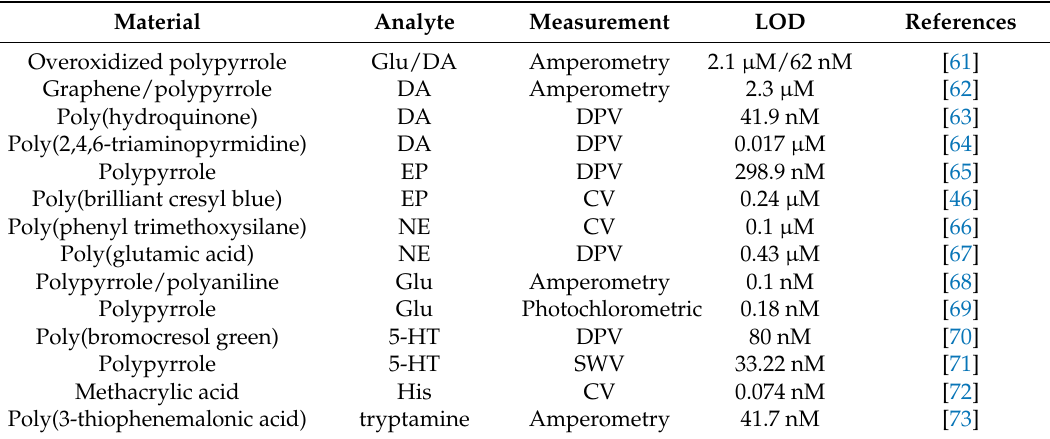
Table 2. Polymer-based sensor for neurotransmitter